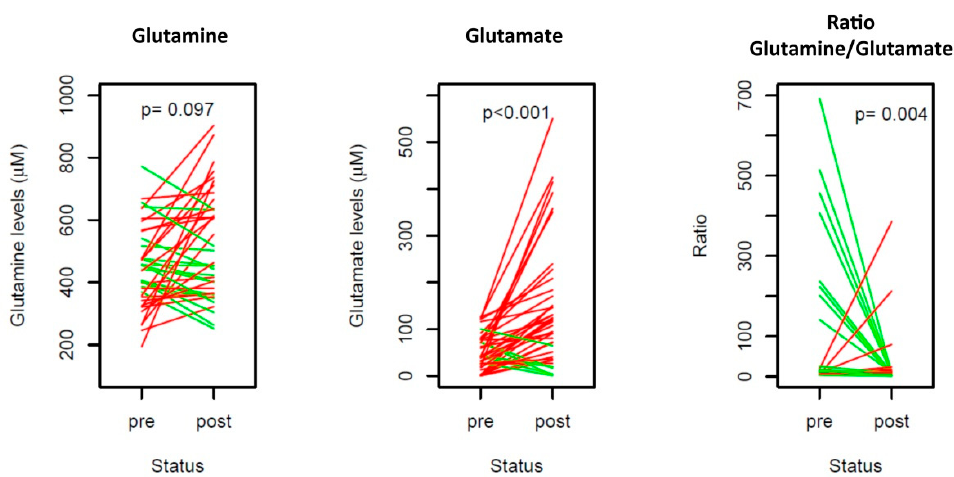
Figure 4. Changes in glutamine, glutamate and their ratio levels from the start of the taxanes treatment (pre) to after the treatment (post). Levels going up and down are represented in red and green, respectively. The Wilcoxon signed-rank test p -value ( p ) is shown.